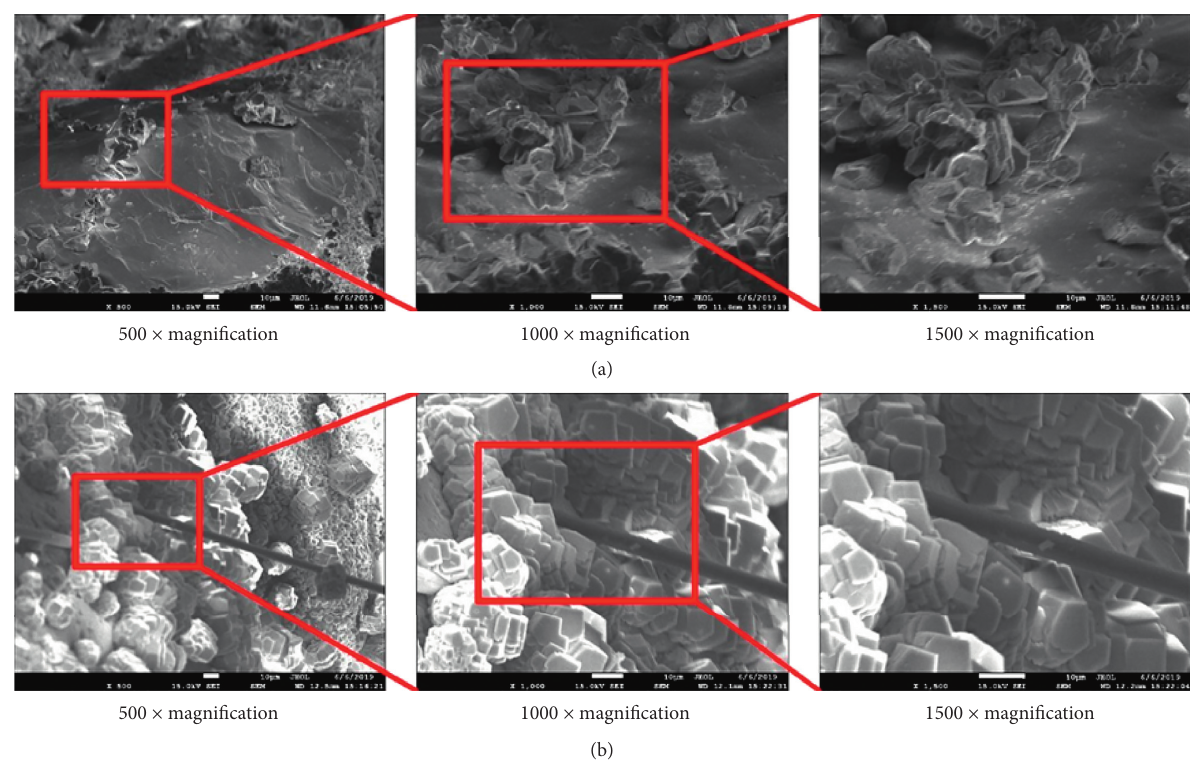
Figure 12: SEM images of silica sand. (a) Without fiber. (b) With fiber.